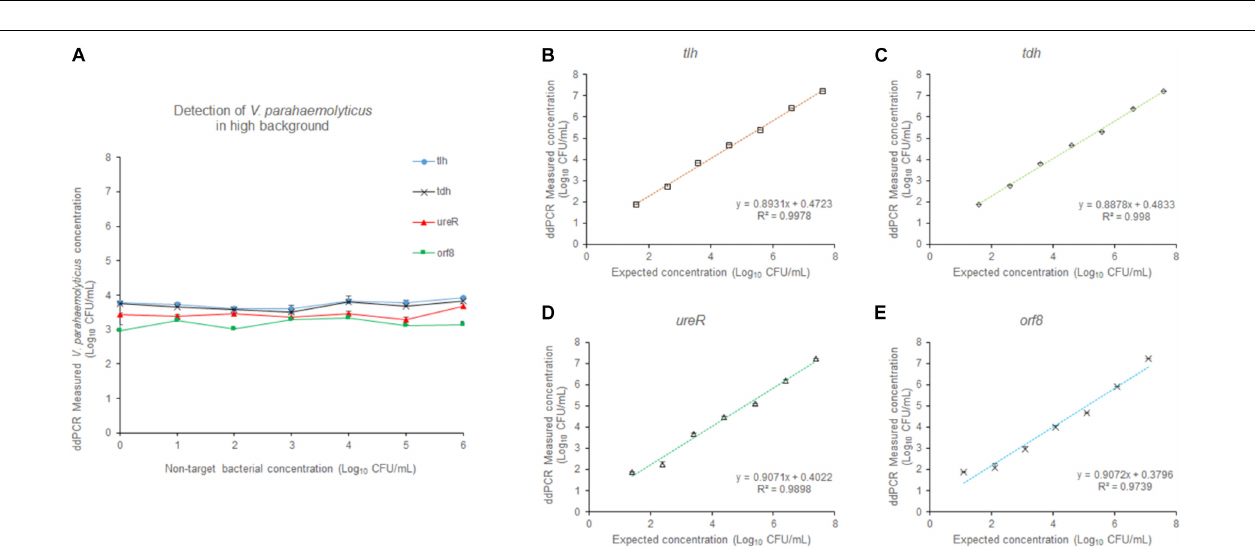
FIGURE 5 | The 2D plot of different targets, the target contains (A) tlh ; (B) tlh , ureR ; (C) tlh , tdh ; (D) tlh , orf8 ; (E) tlh , ureR , and tdh ; (F) tlh , tdh , and orf8 ; (G) tlh , ureR , and orf8 ; (H) tlh , tdh , ureR , and orf8 .